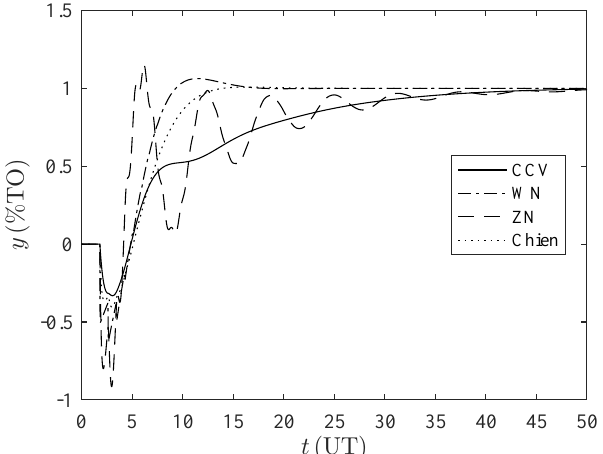
Figure A7. Time response disturbance rejection for the set P 5 . %TO: percentage of transmitter output, UT: units of time.